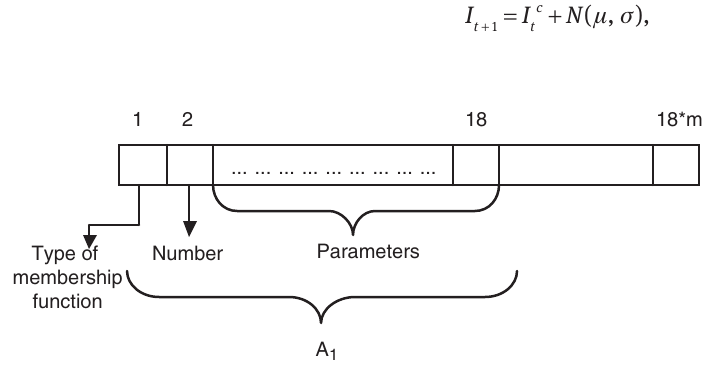
Figure 2: Solution